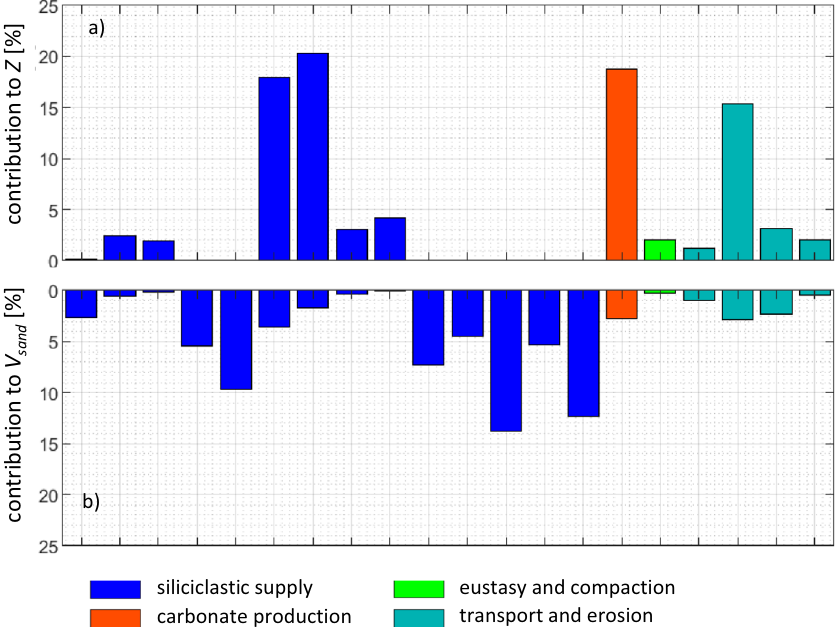
Figure 8. Parameter contributions estimated through Eq. (14) associated with the 20 selected parameters for Z ( a ) and V sand ( b ). Numbers on the x -axis label indicate the parameter number, for their definition see Table 1.